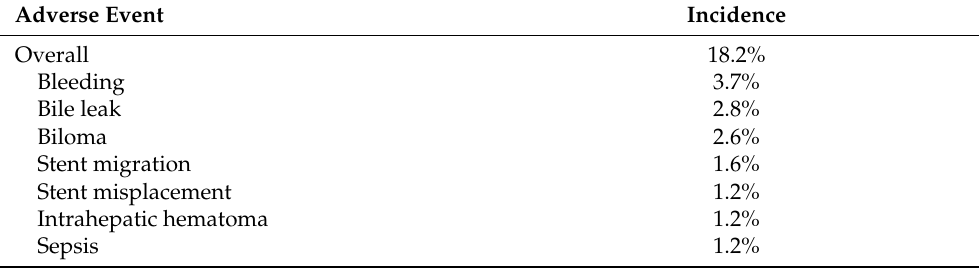
Table 2. Adverse events of